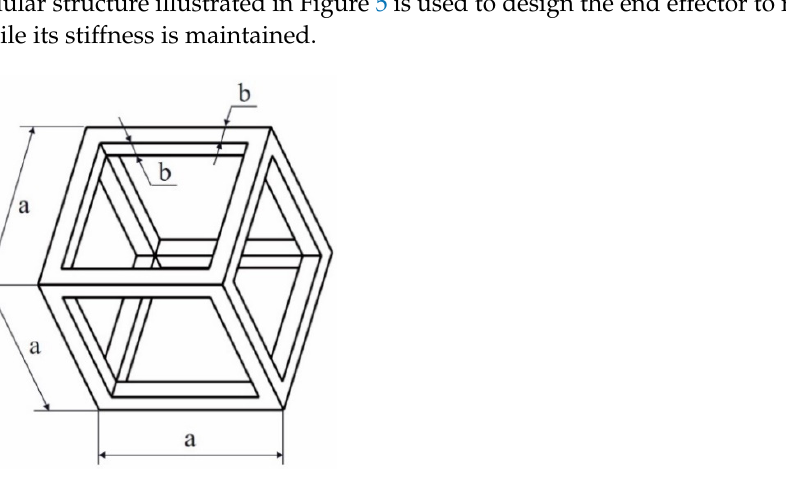
Figure 5. The cellular structure used to design the end effector.